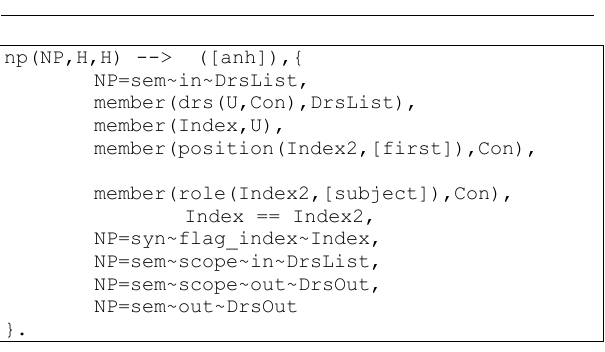
Figure 17. Implement Algorithm 4 based on framework